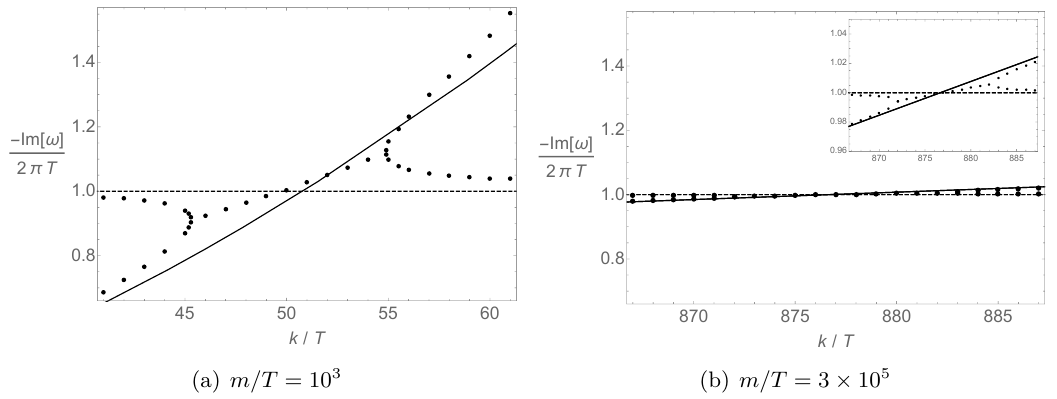
Figure 4 . The upper bound of the charge diffusion constant. The dashed line denotes the upper bound (or the equality) in (3.7).